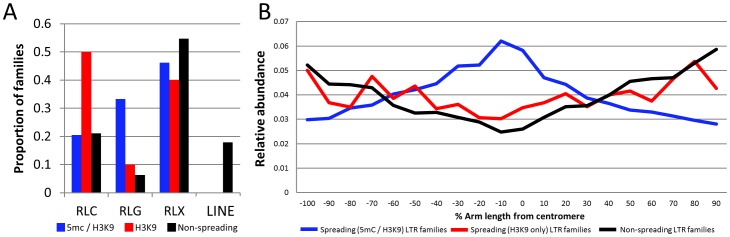
Characterization of retrotransposons that exhibit heterochromatin spreading.(A) The proportion of families within each of the superfamily designations [RLC – copia; RLG – gypsy; RLX – unknown retrotransposon; LINE – LINE elements] is shown for retrotransposons with spreading of both DNA methylation and H3K9me2 (blue), families with H3K9 spreading only (red) and families without spreading (black). (B) The relative abundance of the retrotransposons within each category was determined according to chromosomal position. The retrotransposons in families with spreading (both) are found throughout the maize chromosomes but are enriched in pericentromeric regions relative to the other families. The y-axis provides a normalized estimate of TE abundance along the chromosome (normalized relative to total copy number for each family).